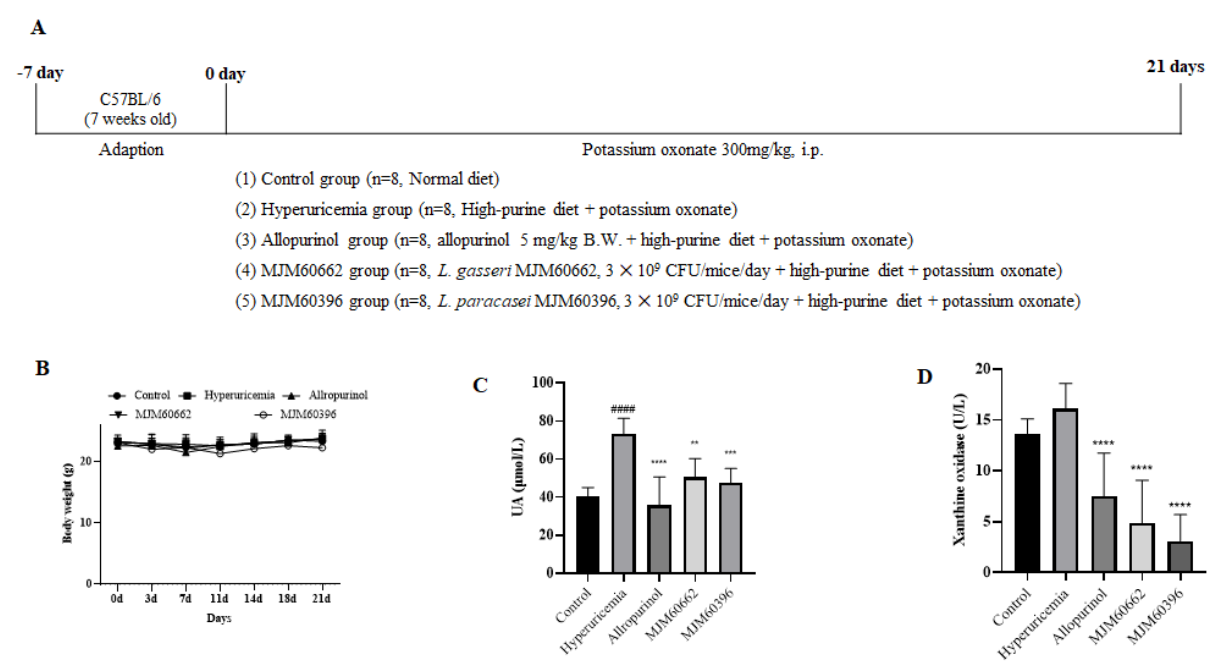
Figure 3. The animal study ( A ) Schematic representation of the experimental schedule. Control group, mice fed with the normal diet; Hyperuricemia group, mice fed with the high − purine diet + Oxonate 300 mg/kg; Allopurinol group, mice fed with the high − purine diet + Oxonate 300 mg/kg + allopurinol 10 mg/kg; MJM60662 group, mice fed with the high − purine diet + Oxonate 300 mg/kg + L. gasseri MJM60662 strain; MJM60396 group, mice fed with the high − purine diet + Oxonate 300 mg/kg + L. paracasei MJM60396. The results are presented as mean ± SD. ( B ) The body weights of mice. ( C ) The uric acid level in serum. ( D ) Serum xanthine oxidase was analyzed by ELISA. #### p < 0.0001 compare with control group, ** p = 0.01, *** p < 0.001, **** p < 0.0001 compare with hyperuricemia